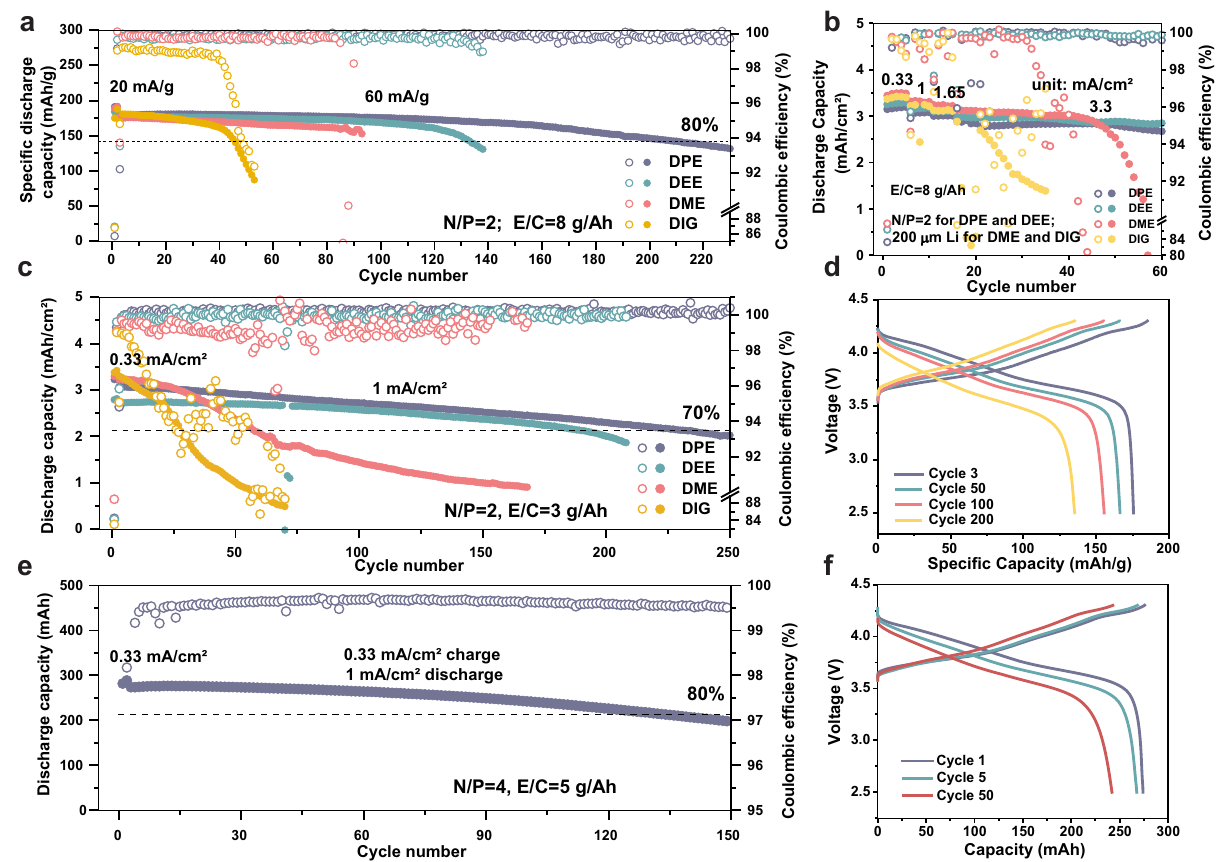
Fig. 6 | Electrochemical testing of the electrolyte solutions in Li||NCM811 coin and pouch cell con fi gurations. All tests were performed at 25°C with Li metal negative electrode, NCM811 positive electrode (3.3 mAh/cm 2 , 16.5mg/cm 2 ), and eachelectrolytecontains1.8MLiFSIsalt. a Longcyclingstudyofthecoincellswith N/Pratio=2,E/Cratio=8g/Ah.Twocycleswereperformedat20mA/g,followedby long-termcyclingat60mA/g.Themassofthespeci fi ccurrentandspeci fi ccapacity referstothemassoftheactivematerialinthepositiveelectrode. b Ratestudyofthe coin cells with different electrolytes at 0.33, 1, 1.65, and 3.3mA/cm 2 . c , d Lean